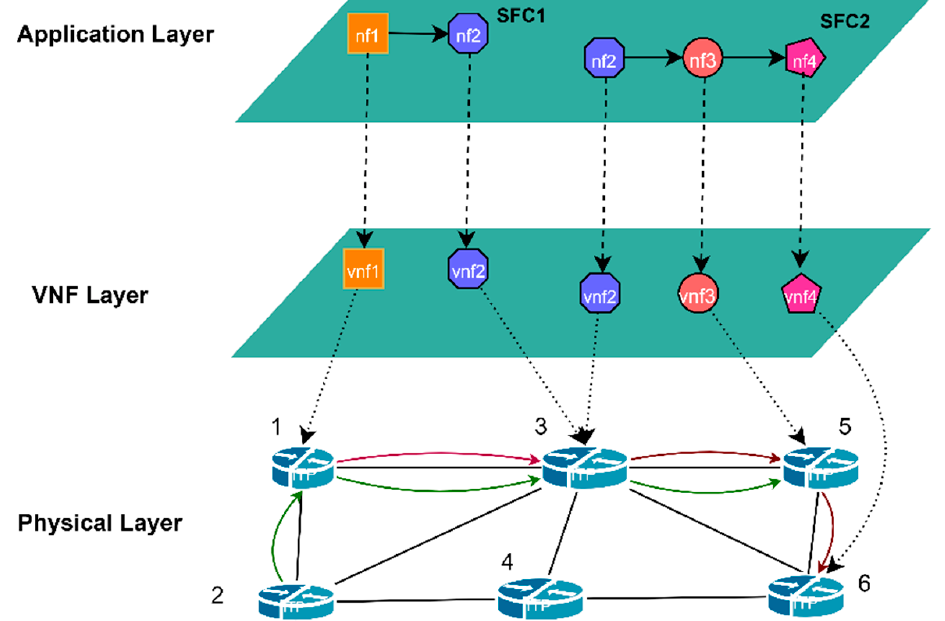
Figure 1. Three-layer NFV network architecture. Table 1. Notations used in the model.